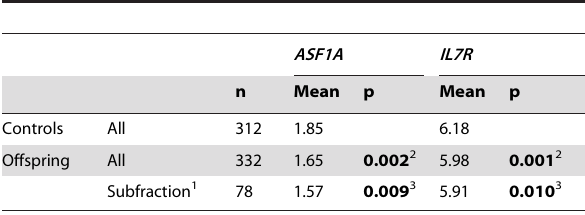
Table 3. Gene expression levels of ASF1A and IL7R in all as well as subfraction of offspring compared to